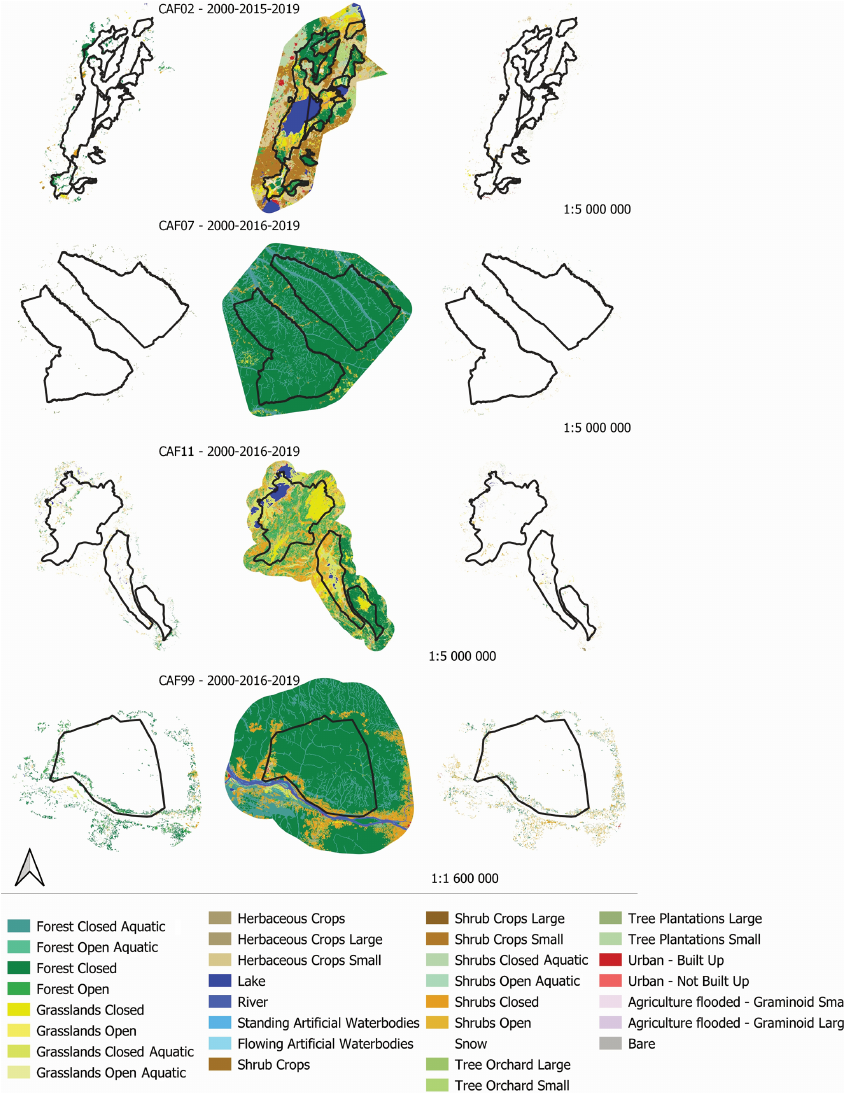
Figure 5. Key landscapes for conservation – modular classification level. The boundaries (black polygons) represent protected areas (IUCN category I–IV – UNEP-WCMC and IUCN, 2021) within the KLCs. Both land cover and land cover change maps are presented for each KLC. CAF02: Greater Virunga; CAF07: Salonga; CAF11: Upemba; CAF99: Yangambi. Year-2000 datasets are available in Szantoi et al.